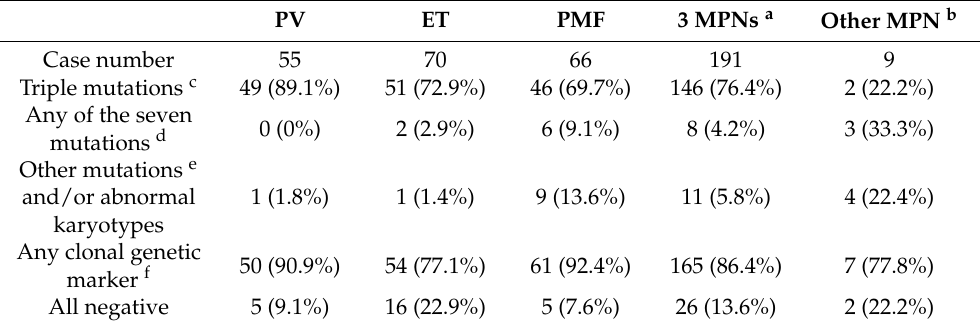
Table 2. Proportion of patients possessing a clonal genetic marker after applying sequential criteria for genetic